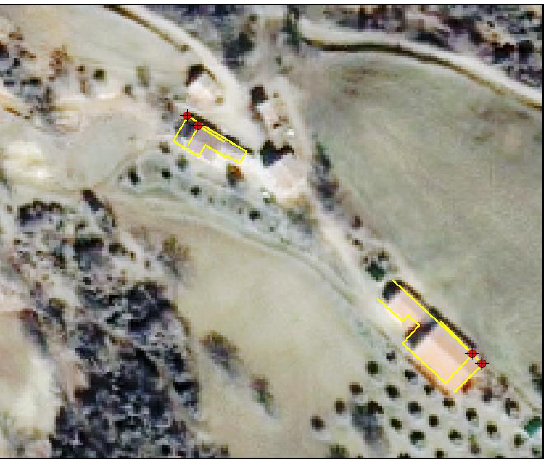
Figure 8. Comparison between control points (test 1)